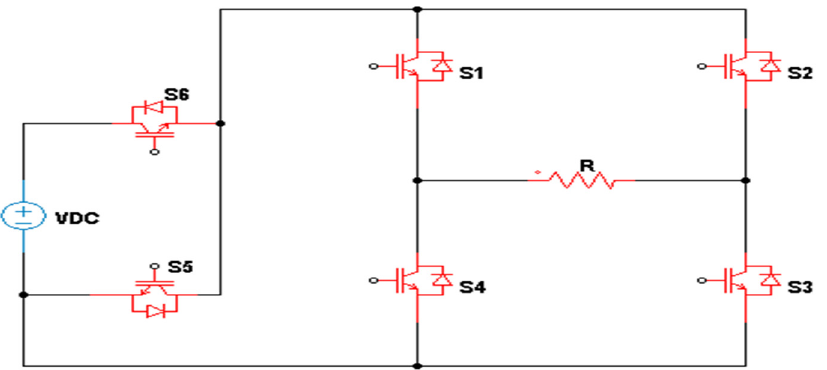
Figure 7. Three-level inverter.